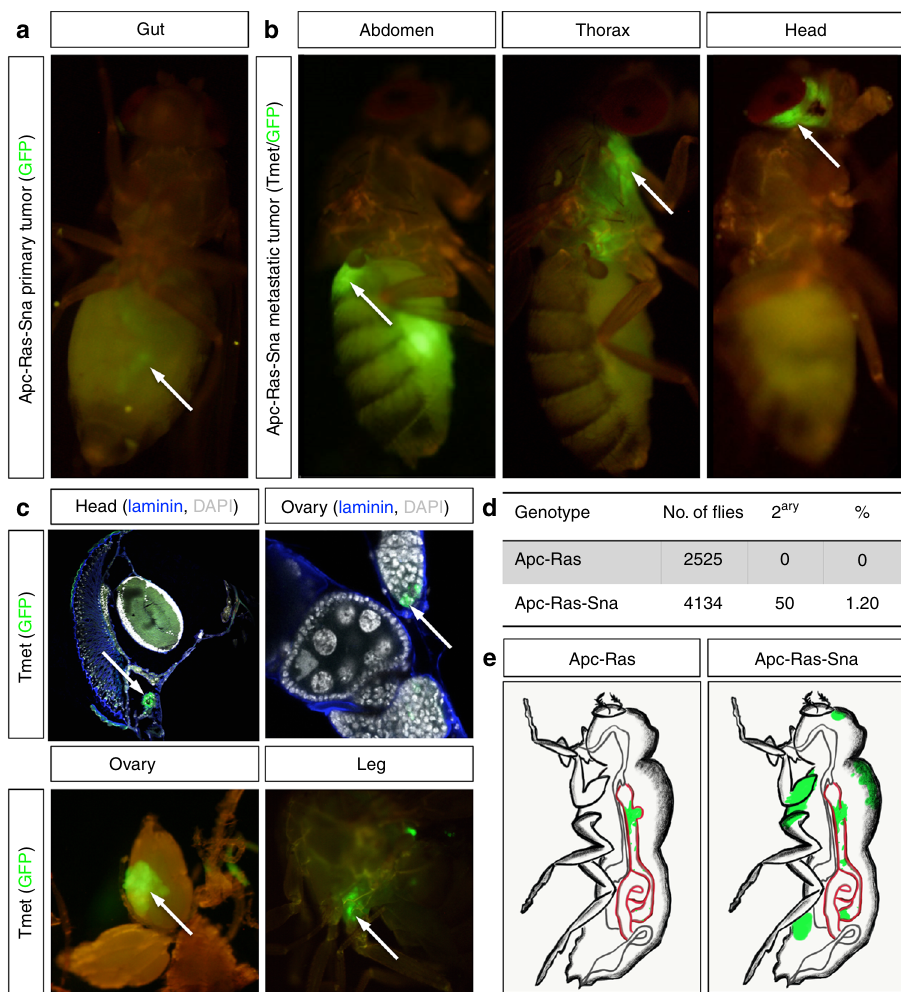
Fig. 1 Snail expression in Apc-Ras intestinal tumors induces formation of metastases. a Apc-Ras-Sna primary tumors, labeled with green fl uorescent protein (GFP), are localized in the midgut (arrow). b , c Apc-Ras-Sna metastatic tumors (TMets) are found in multiple distant locations outside the gut, including the abdomen, thorax, and head ( b , arrows), and invade other tissues such as the brain, ovaries, and legs ( c , arrows). d Numbers of Apc-Ras and Apc-Ras- Sna fl ies in which TMets are found. e Cartoon depicting Apc-Ras tumors (green) con fi ned to the midgut (red), while Apc-Ras-Sna tumors are able to seed TMets in multiple distant